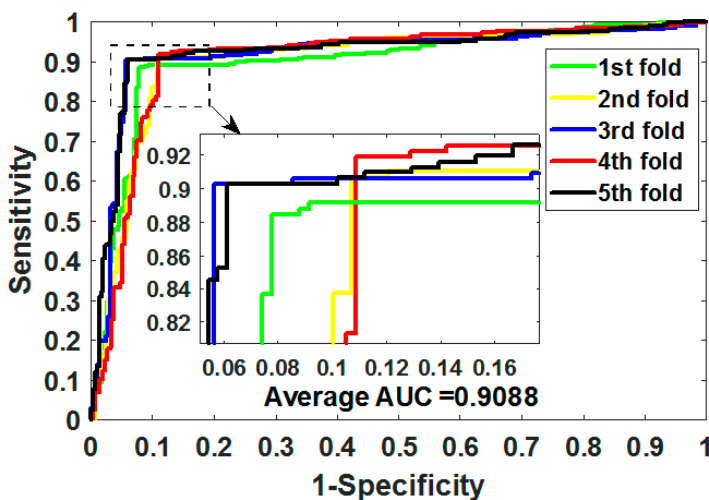
Figure 3. ROC of 5CV mapped by MSPEDTI on ion channel dataset.